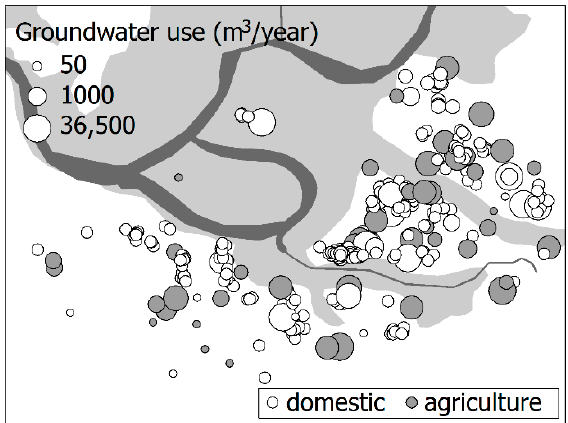
Figure 3. Groundwater use in the study area.